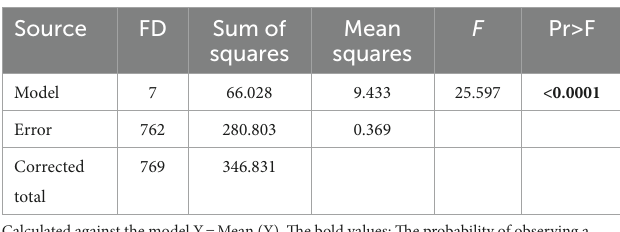
TABLE 13 ANOVA cognitive level and historical concepts.